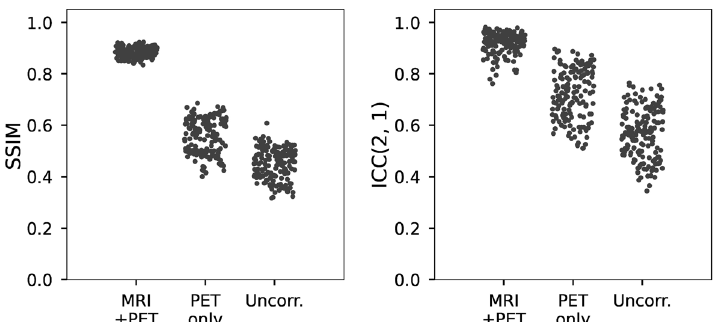
Table 1 Comparison of SSIM and ICC(2,1) among the deepPVC models for 156 subjects pooled from the six cross-validation datasets